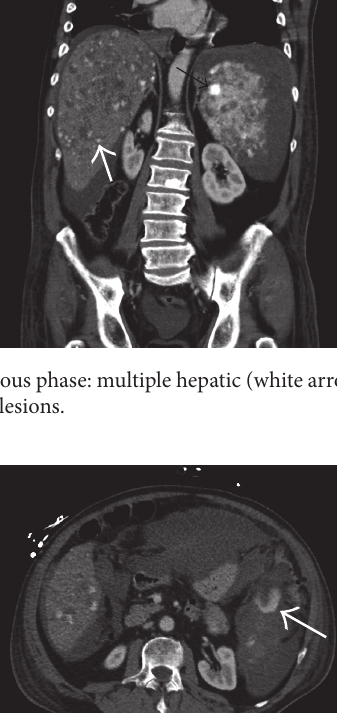
Figure 2: Arterial phase of contrast-enhanced CT scan depicts multiple hypervascular lesions in the spleen (black arrow) and liver (white arrow).